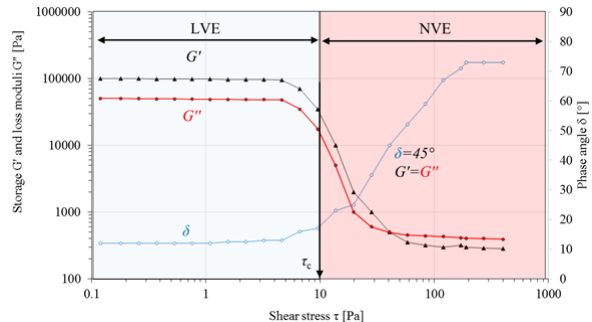
Figure 5 . Shear elastic modulus as a function of shear stress. The oscillation frequency is 1 Hz and the shear stress is increased from 0.1 to 400 Pa. A lower shear stress is possible but might cause large data